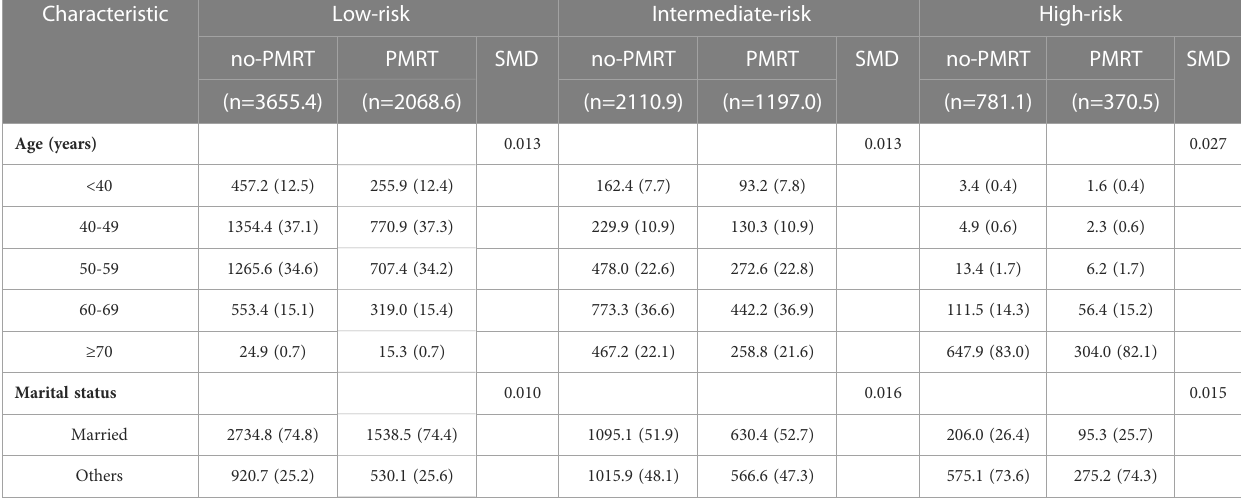
TABLE 3 The baseline characteristics of the patients in the IPTWs-adjusted cohort based on OS.